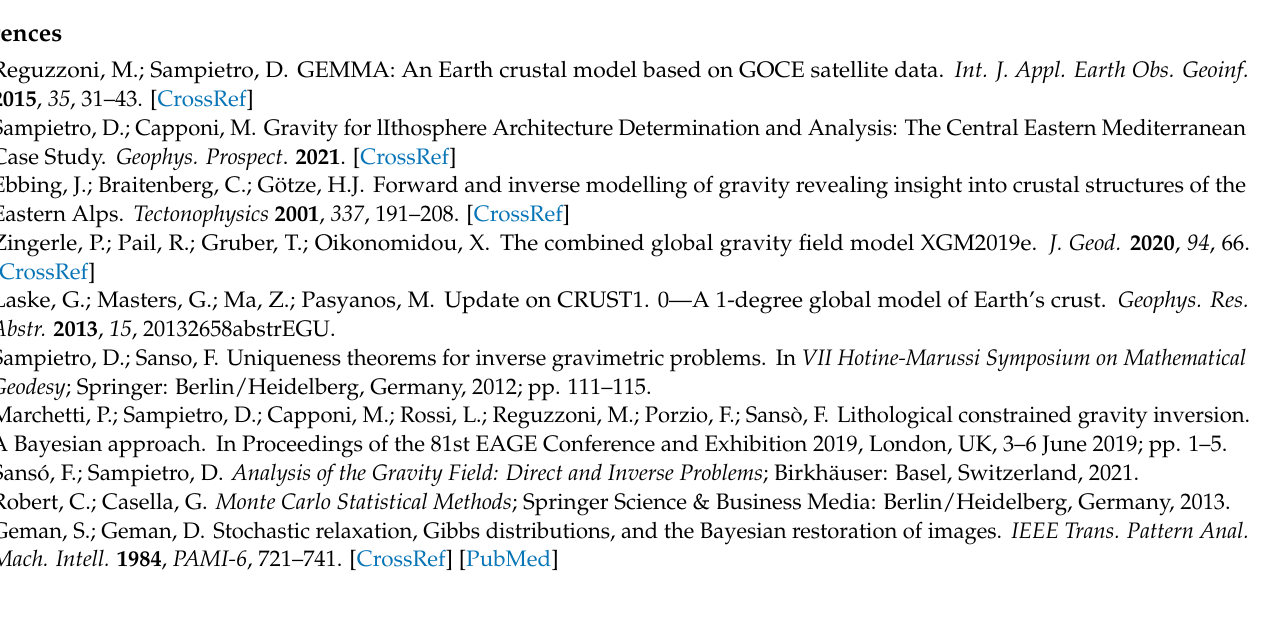
Figure A1. Available seismic profiles observing the bathymetry over the considered area ( a ). Empiri- cal and theoretical variograms ( b ). Estimated bathymetry from the seismic profiles ( c ) and predicted accuracy in terms of STD ( d ). Random realisation of possible deformation ( e ). Possible realisation of bathymetry coherent with seismic data ( f